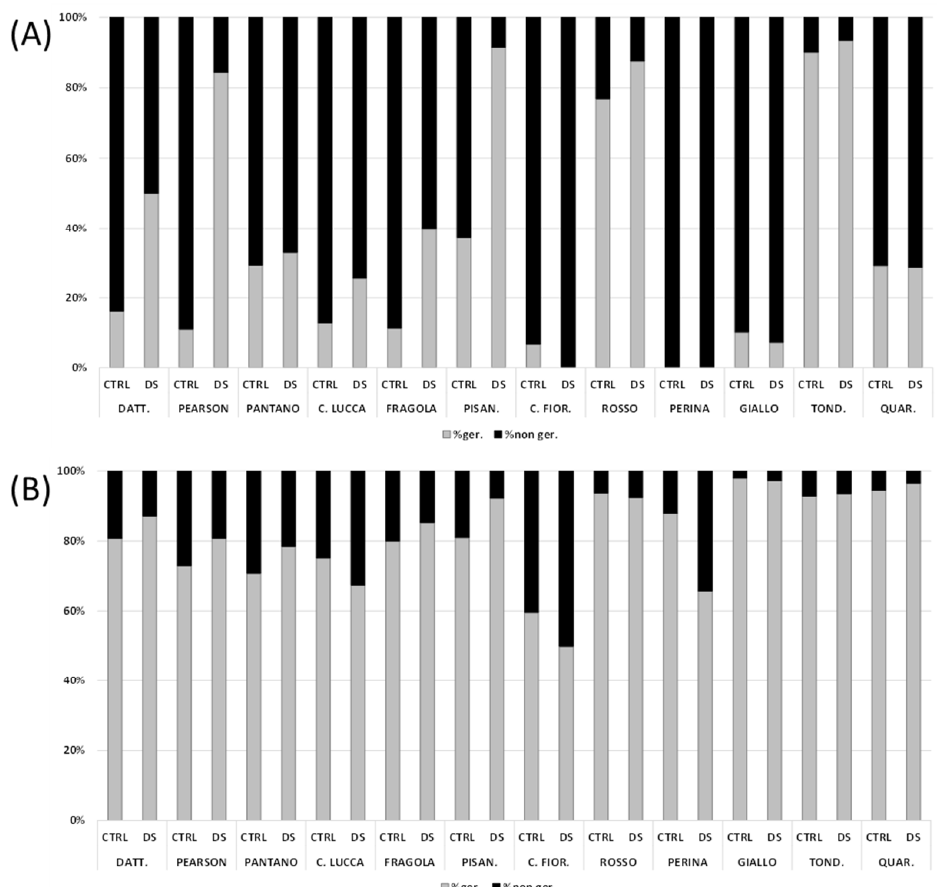
Figure 2. ( A ) Seed germination after 4 days expressed in percentage. ( B ) Seed germination after 8 days expressed in percentage. In black the percentage of non-germinated seeds and in gray the percentage of germinated seeds. CTRL indicates the control group of tomato, and DS the drought-stressed group.